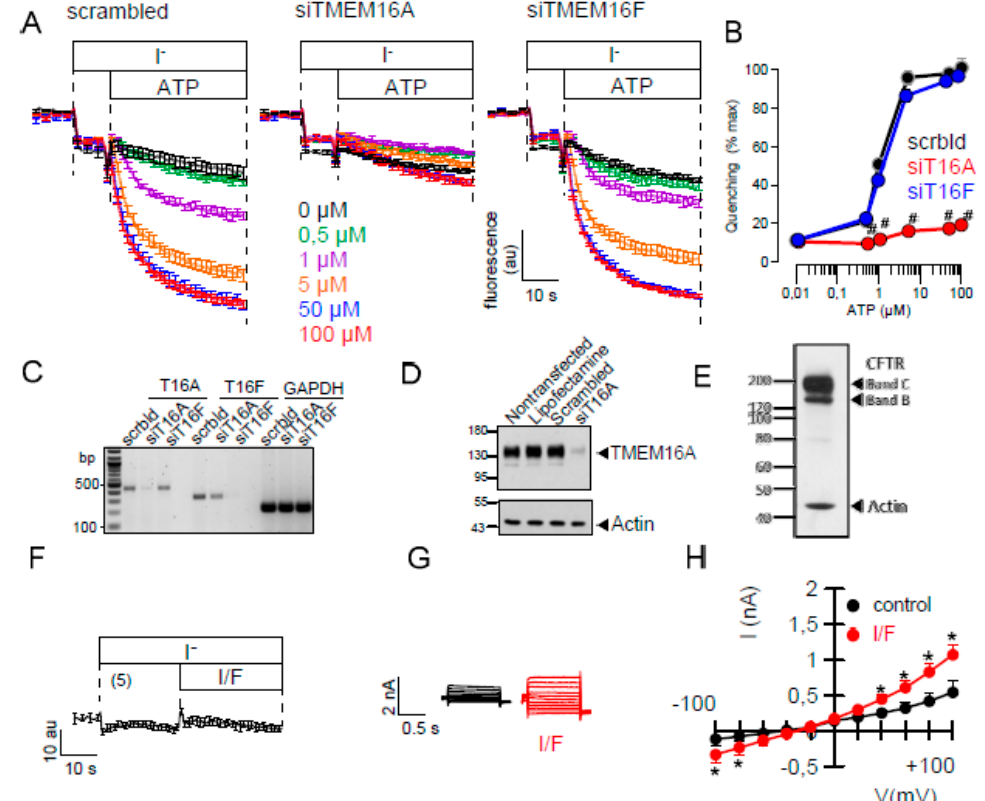
Figure 1. Endogenous Ca 2 + -dependent TMEM16A and cAMP-activated CFTR Cl − transport in HT 29 colonic epithelial cells. ( A , B ) YFP fluorescence quenching by iodide is enhanced by ATP in a concentration-dependent manner ( n = 5 for all). siRNA knockdown of TMEM16A but not TMEM16F inhibits quenching. ( C ) Semiquantitative RT-PCR indicates knockdown of TMEM16A (T16A; 92%, n